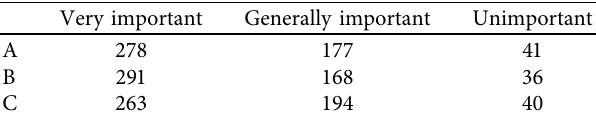
Table 4: Survey results of students majoring in physical education on their cognition of innovative technological ability.